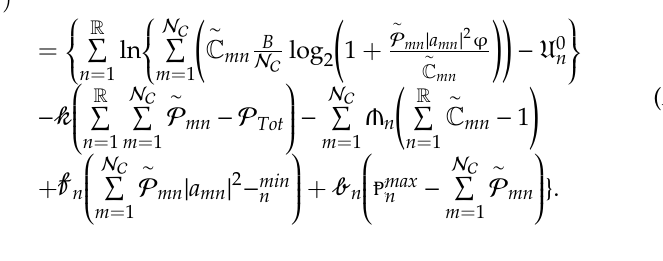
Table 2. List of